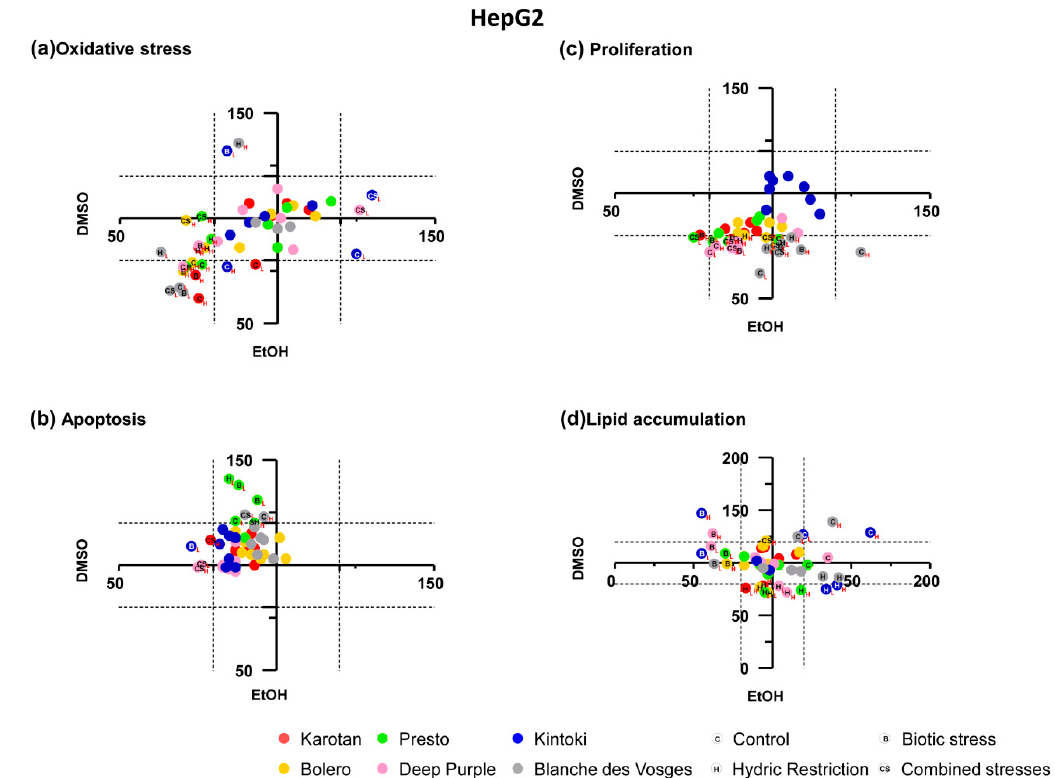
Figure A3. E ff ect of carrot extracts on hepatocytes. Oxidative stress ( a ), apoptosis ( b ), proliferation ( c ) and lipid accumulation ( d ) in HepG2 after treatment with carrot extract from di ff erent carrot varieties and growing conditions. In each diagram, x-axis and y-axis expressed percentage response values of ethanol and DMSO samples, respectively. Variations of less than 20% of responses (included in dot lines) were not considered biologically